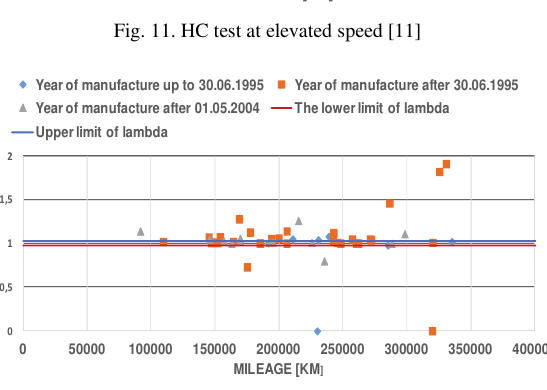
Fig. 11. HC test at elevated speed [11]